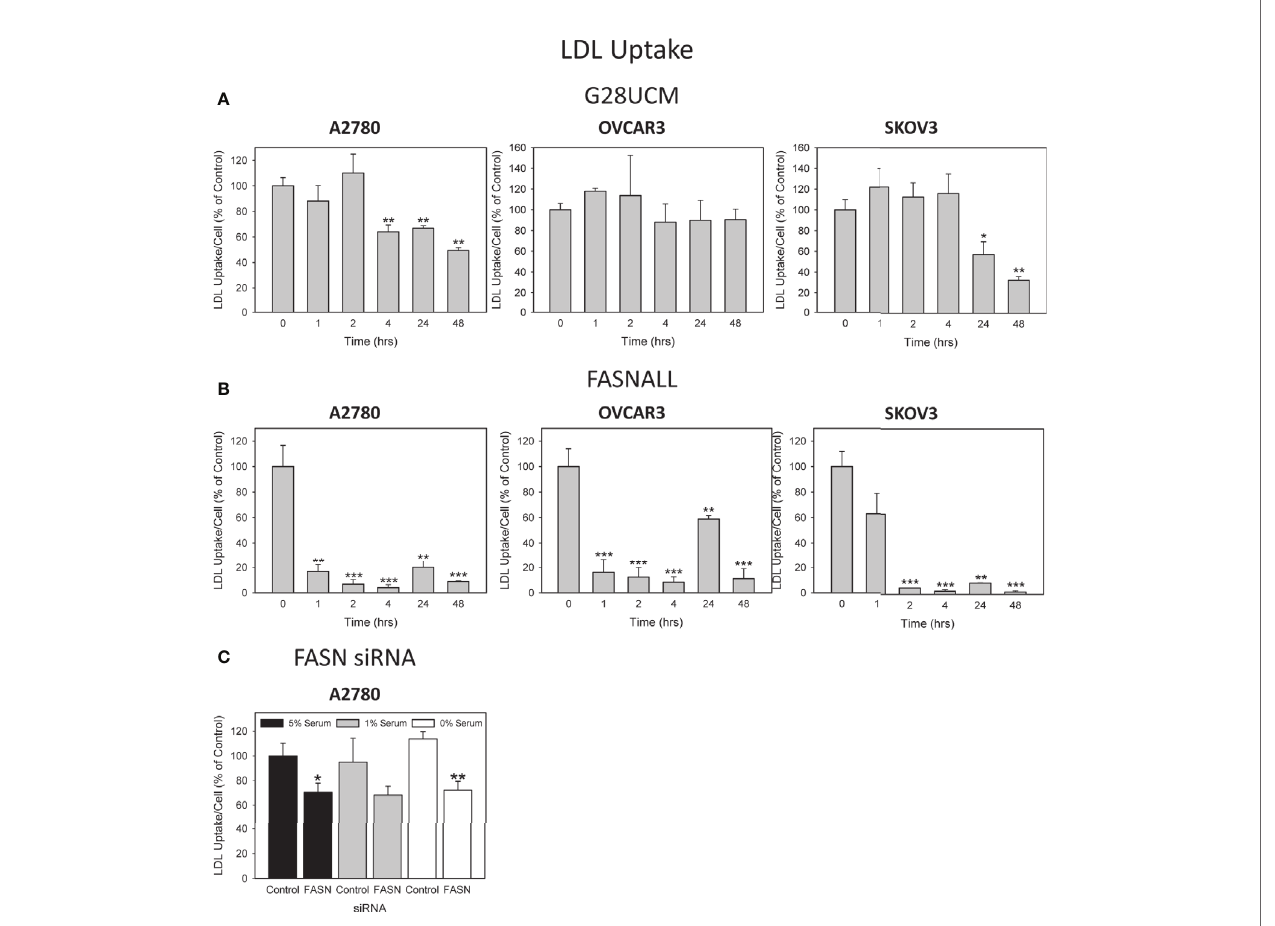
FIGURE 5 | The effect of inhibition of endogenous de novo fatty acid synthesis on the uptake of exogenously supplied LDLs in OC cells. A2780, OVCAR3 and SKOV3 cells were cultured in media containing 1% serum and were exposed for 0 – 48 hours to the optimal concentrations (as determined in Figure 3 ) of the FASN inhibitors G28UCM (1.25, 2.5, 10 µM for A2780, OVCAR3 and SKOV3) (A) or Fasnall (25, 50, 100 µM for A2780, OVCAR3 and SKOV3) (B) before LDL uptake was determined by the pHrodoTM Red LDL Uptake Kit as described in Materials and methods. Fluorescence signals were normalized to cell numbers that have been determined in parallel by formazan dye cell proliferation assays and were expressed in % of vehicle(0.1% DMSO)-treated control cells. Means ± SD, n = 3. ANOVA followed by Scheffe test, p < 0.05 (*), p < 0.01 (**) and p < 0.001 (***) relative to vehicle-treated cells. (C) A 48-hours knock-down of FASN by speci fi c siRNAs inhibits the uptake of exogenously supplied LDL. Comparison of the data in the presence of 5%, 1% or 0% serum reveals that reduction of concurrent lipid contained in the serum can support the uptake of pHrodoTM Red LDL in the control transfectants, but cannot reverse reduction of LDL uptake when FASN was knocked-down. Fluorescence signals were normalized to cell numbers that have been determined in parallel by formazan dye cell proliferation assays and were expressed in % of Control (cells transfected with non-targeting control siRNA). Means ± SD, n = 3. One-tailed Student ’ s t-test at p < 0.05 (*) and p < 0.01 (**) between cells transfected with FASN- targeting siRNA (FASN) or with non-targeting control siRNA (Control) grown in the presence of the corresponding concentration (5%, 1% or 0%) of